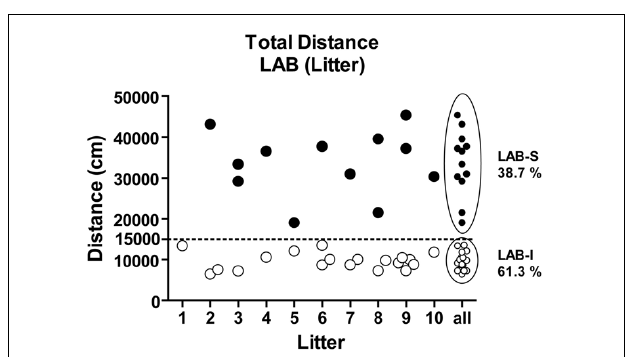
FIGURE 5 | LAB mice by different litters. Analysis of LAB’s individual total distance traveled by litter revealed that LAB-S mice were evenly distributed across different breeding